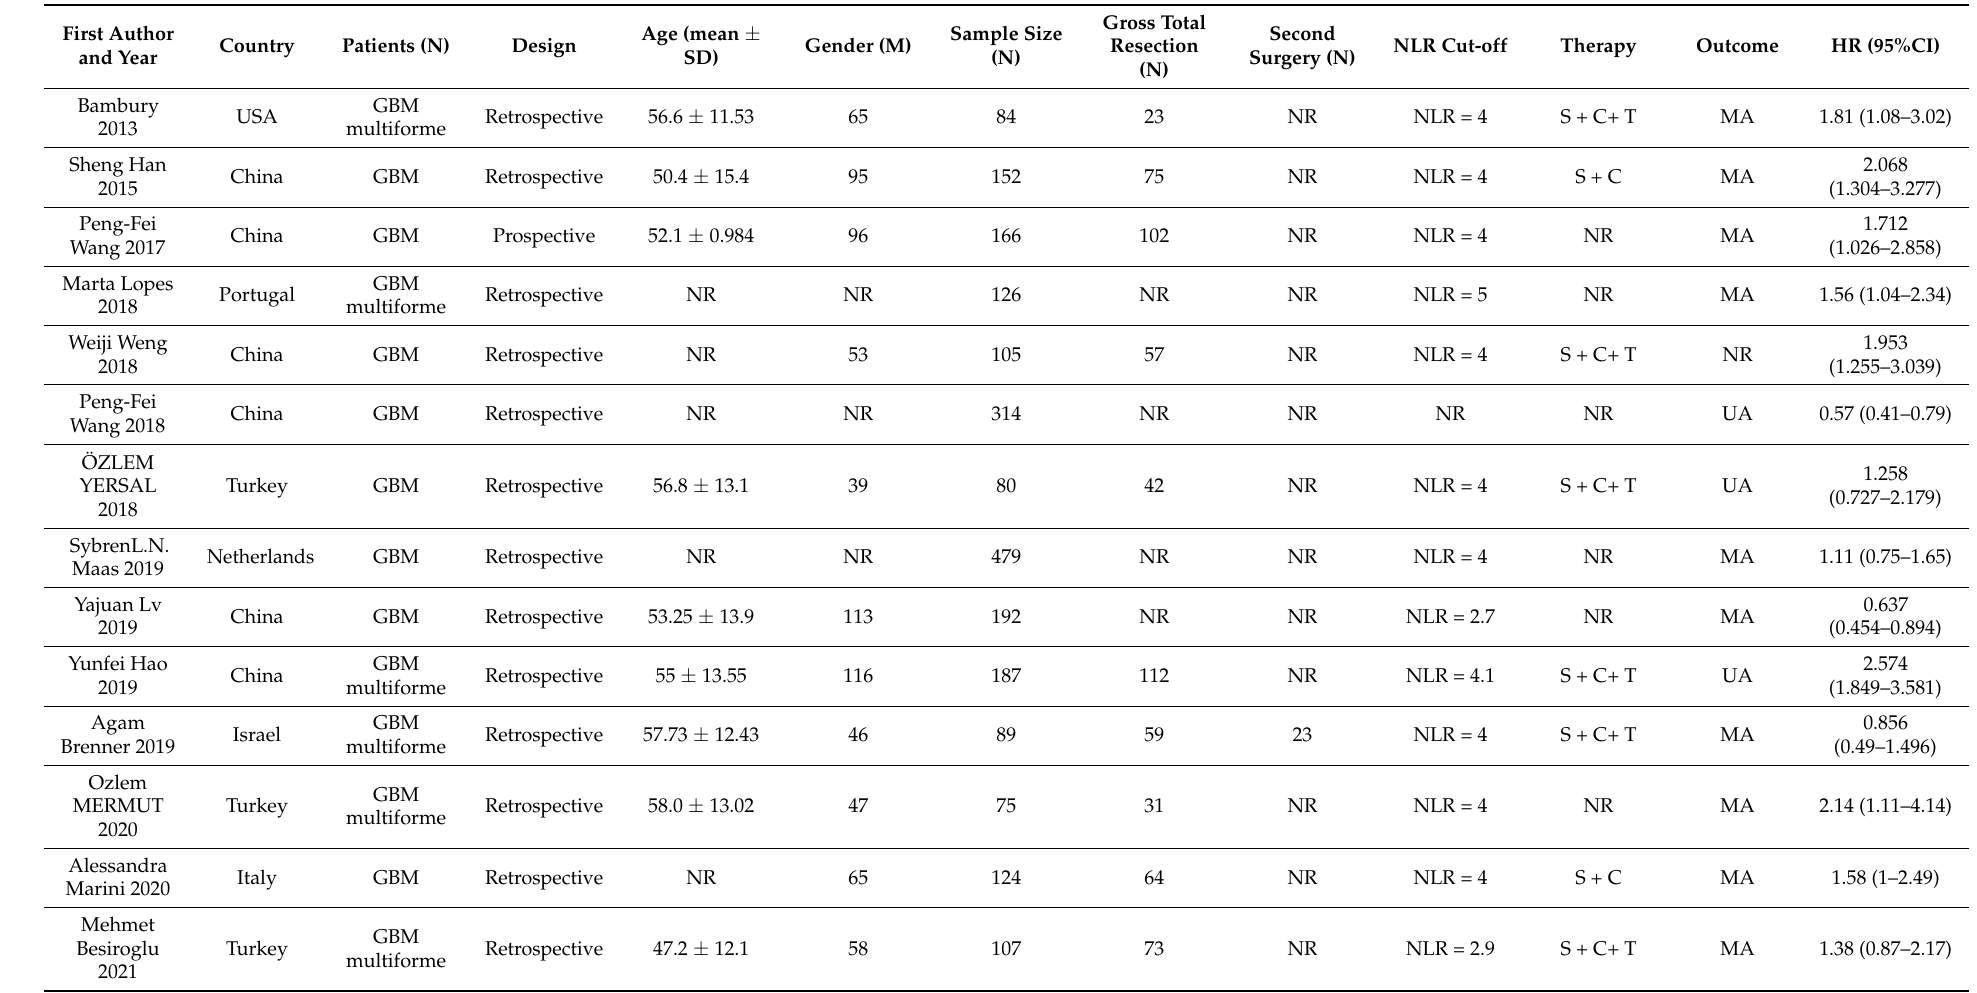
Table 1. Main characteristics of 19 studies included in